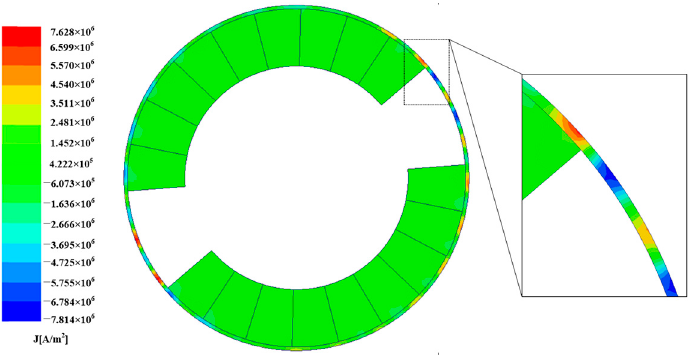
Figure 12. The eddy current density distribution of the permanent magnet and the 1 mm jacket.